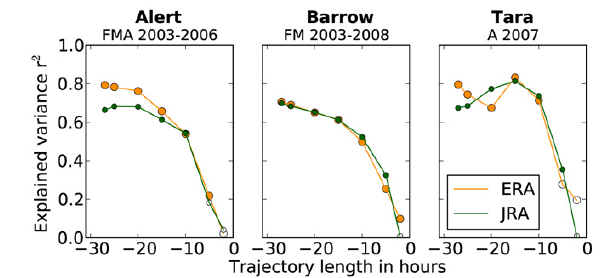
Fig. 11. Explained variances of temperature difference between the model starting temperature and the observed 2-m air temperature at the station and mean sensible heat flux along the trajectories (TV method) for Alert, Barrow and Tara (AA) as a function of trajectory length using a BL depth of 350m. The filled circles are significant at the 95%